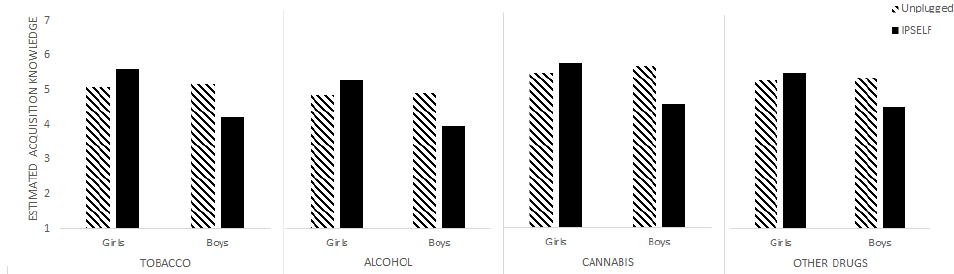
Figure 4. Estimated acquisition of new knowledge about tobacco, alcohol, cannabis and other drugs by program and gender.